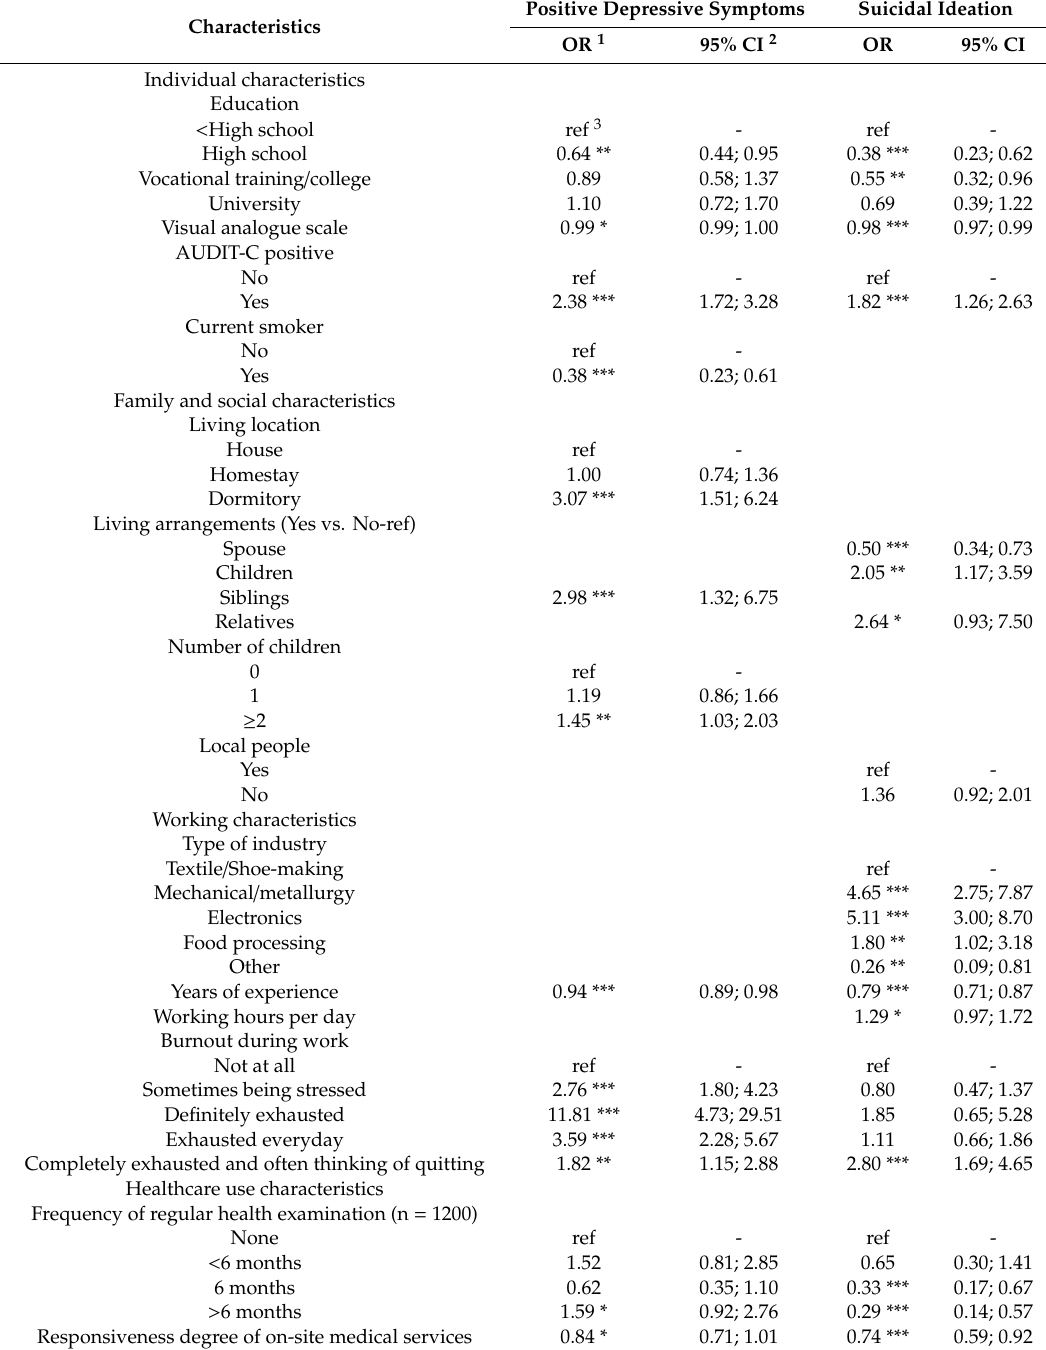
Table 4. Associated factors with depressive symptoms and suicidal